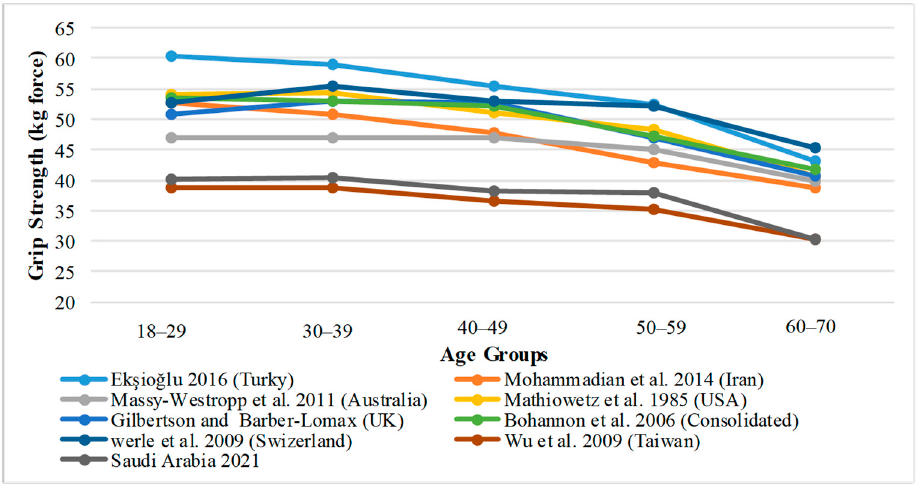
Healthcare 2021 , 9 , x FOR PEER REVIEW Figure 6. Male, regional reports of mean grip strength by age groups. Figure 6. Male, regional reports of mean grip strength by age groups.